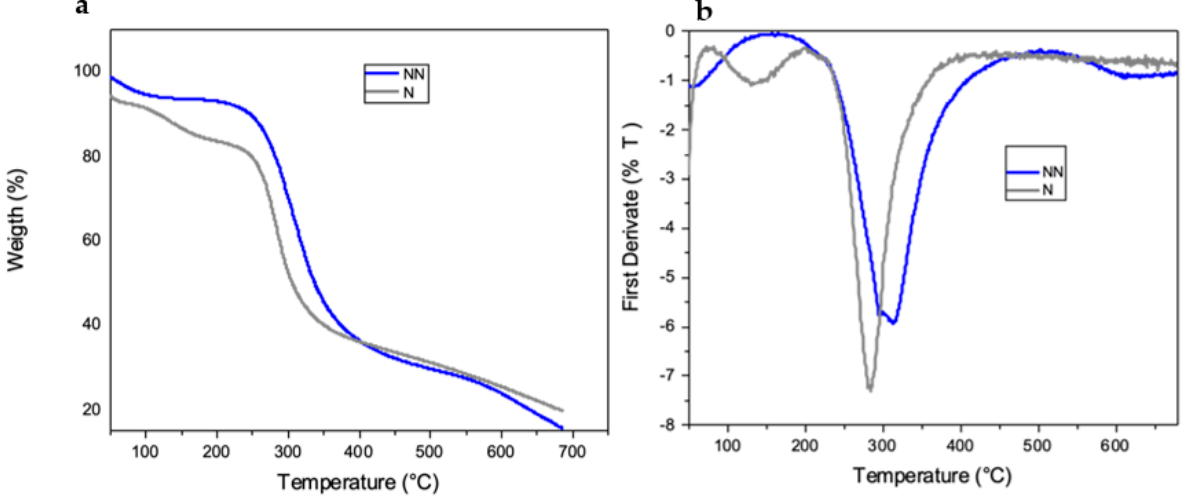
Figure 4. ( a ) Thermogravimetric analysis (TGA) and ( b ) DTGA thermograms of neutralized (N) and non-neutralized (NN) AH-crosslinked chitosan. Table 2. Decomposition temperatures and weight loss of neutralized (N) and non-neutralized (NN) AH-crosslinked chitosan.